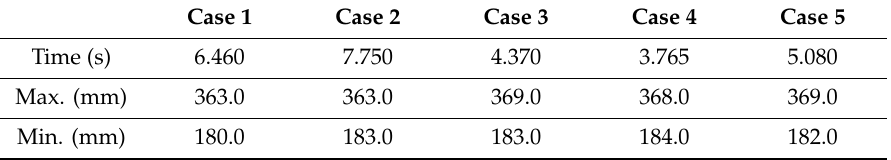
Table 4. Summary of slushing heights generated by earthquakes of different shapes.